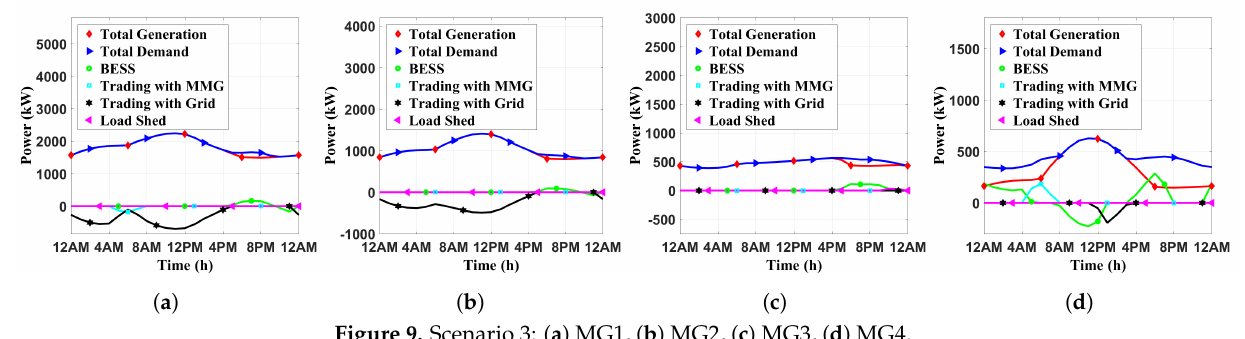
Figure 9. Scenario 3: ( a ) MG1, ( b ) MG2, ( c ) MG3, ( d ) MG4.